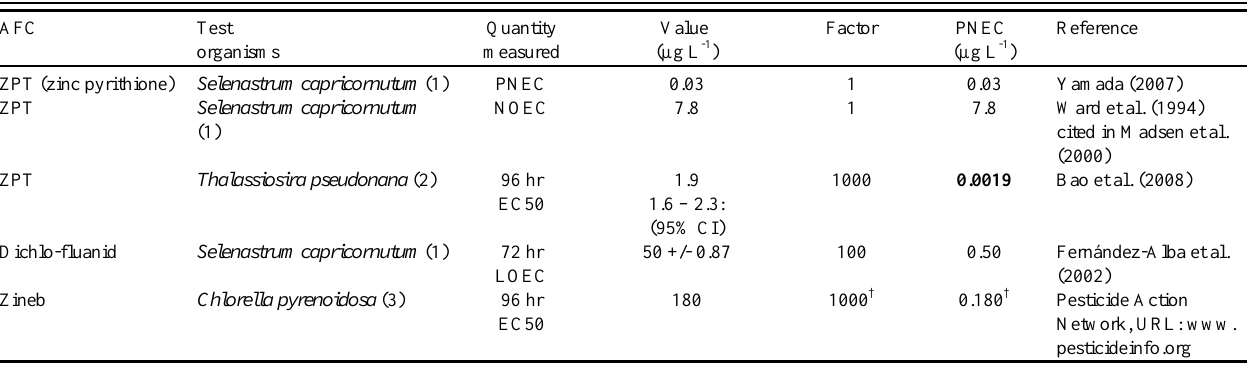
Table 4 . Derivation of predicted no-effect concentration (PNEC) values for anti-fouling compounds (AFC). The value used in the Loch Fyne simulation are shown in bold. AFC Test organisms